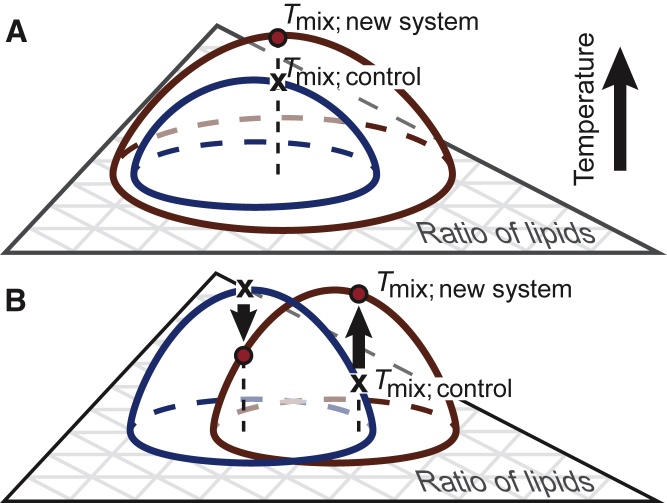
Two scenarios of how miscibility transition temperatures (the curved surfaces) may shift in response to changes in the composition of a membrane. The Gibbs phase triangle in the x-y plane contains all possible ratios of the three components of the ternary membrane. (A) shows an increase in Tmix over all lipid ratios, upon moving from the control to the new system. (B) shows an increase in Tmix for some lipid ratios (upward arrow) and a decrease for others (downward arrow). To see this figure in color, go online.